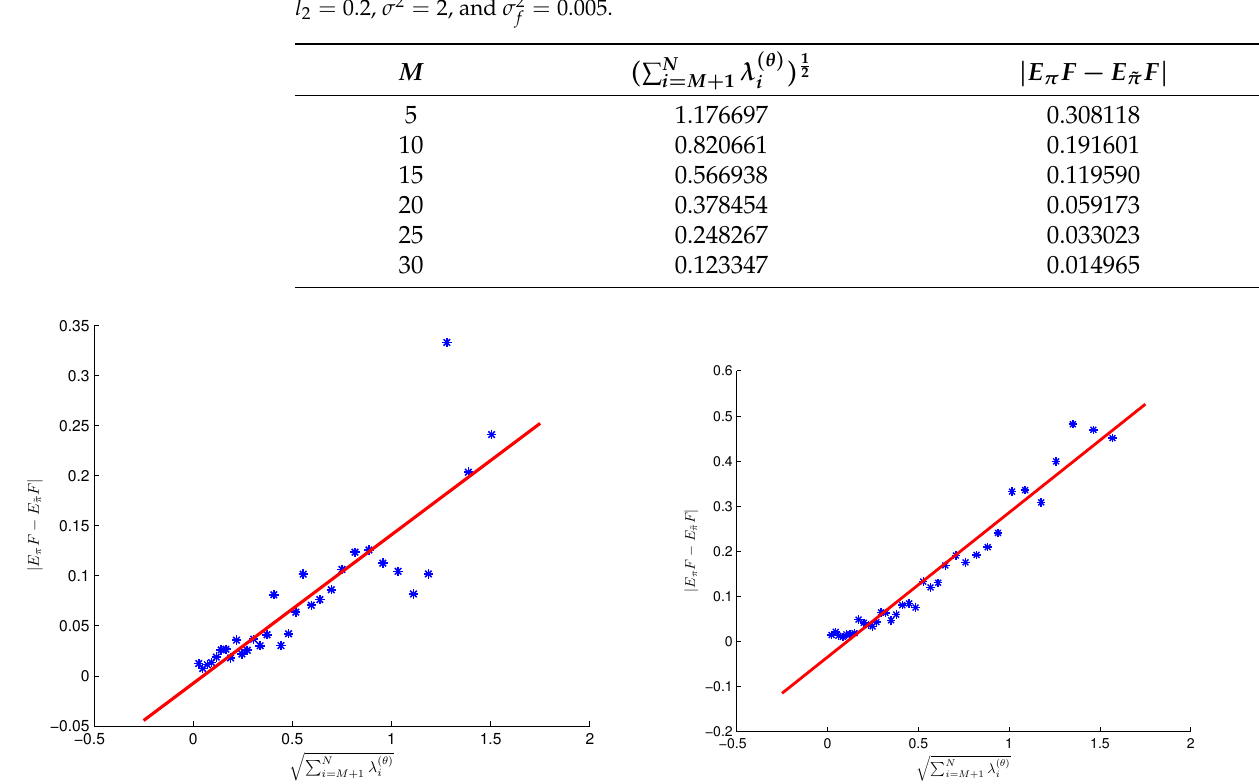
( θ ) ( ∑ N ) 1 2 , E π F E ˜ π F λ . Left : l 1 = 0.1, l 2 = 0.4, σ 2 = 2, and σ 2 i = M + 1 i { | − |} = f